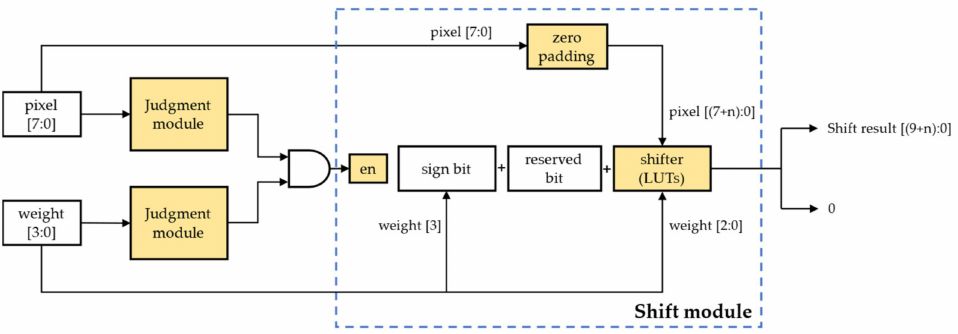
Figure 6. The shift-based multiplication processing